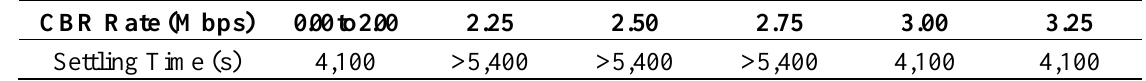
Figure 10. Total energy consumption (modified